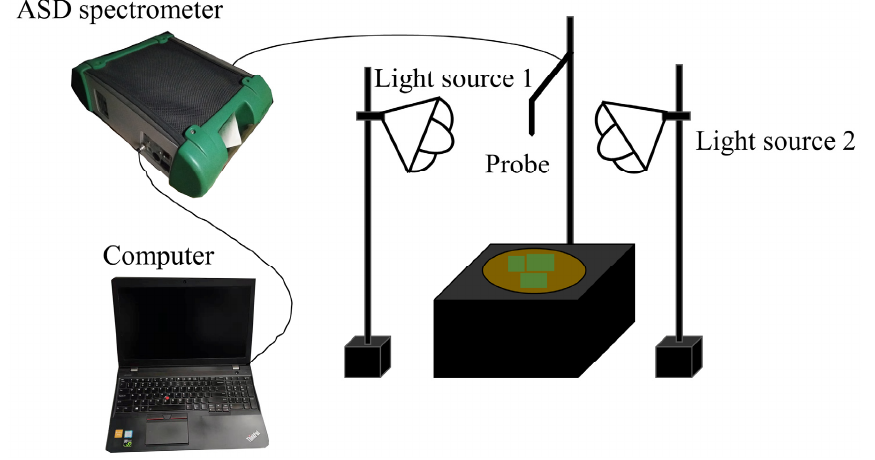
Figure 2. Schematic diagram of spectral